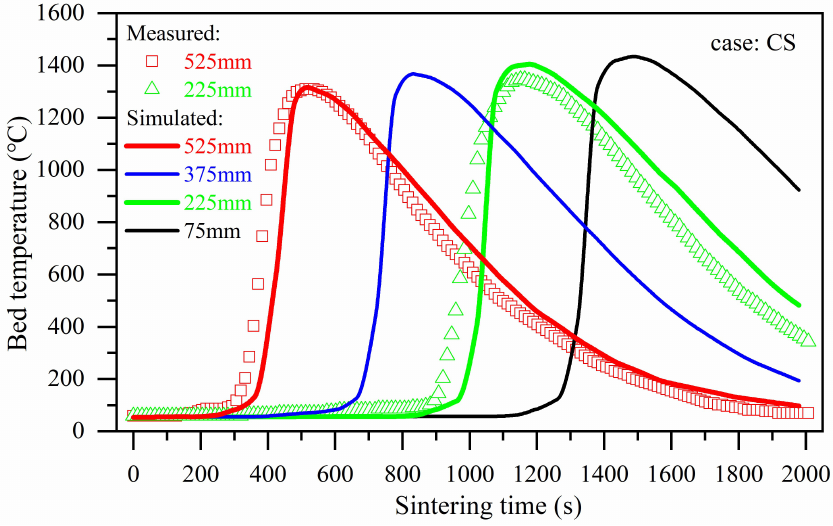
Figure 3. Comparisons between simulated and measured data of bed-layer temperature.